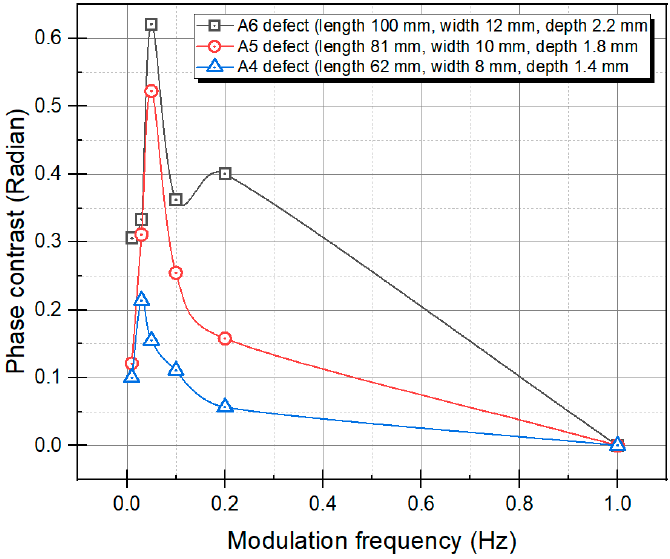
Figure 14. Phase contrast trend according to modulation frequency by FFT.